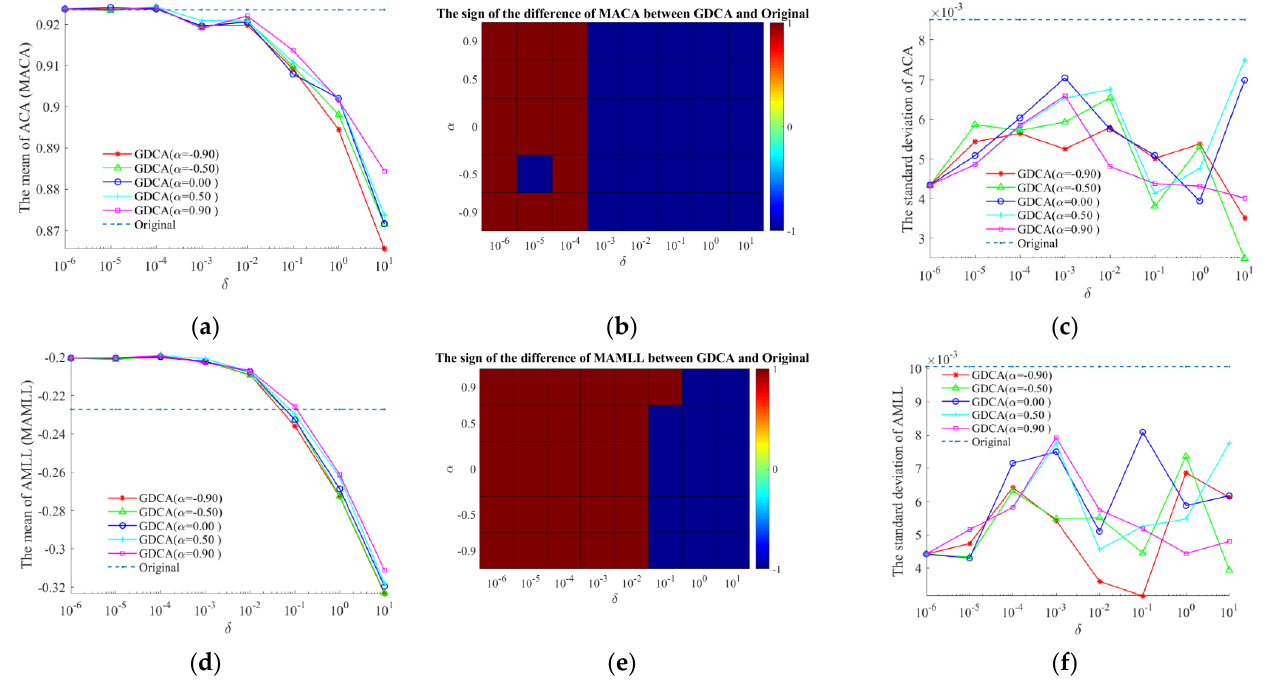
Figure 11. Comparisons between GDCA driven SVM and original SVM regarding the mean and standard deviation of all the Monte − Carlo experiments for ACA and AMLL. ( a ) The mean of ACA (MACA). ( b ) The sign of the difference of MACA. ( c ) The standard deviation of ACA. ( d ) The mean of AMLL (MAMLL). ( e ) The sign of the difference of MAMLL. ( f ) The standard deviation of